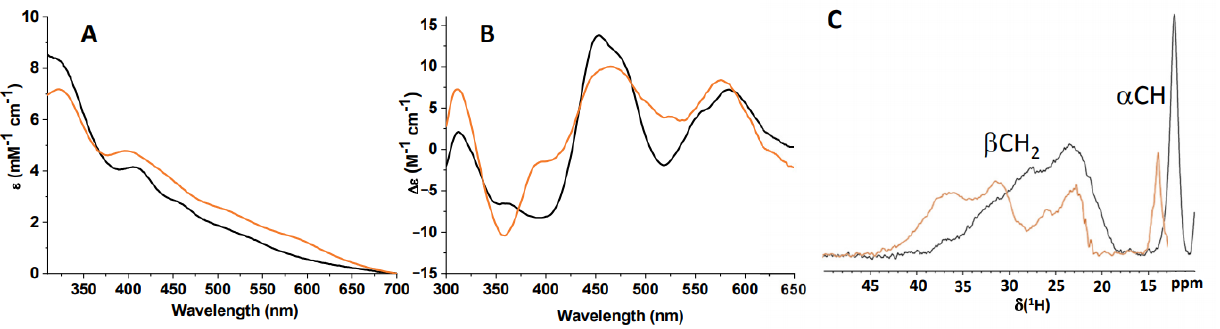
Figure 6. C59Y BOLA3–GLRX5 complex bound a [2Fe–2S] 2+ cluster. UV–VIS ( A ), UV–VIS CD ( B ), and paramagnetic 1D 1 H NMR spectra ( C ) of chemically reconstituted C59Y BOLA3–GLRX5 (black) and BOLA3–GLRX5 (orange) apo complexes.